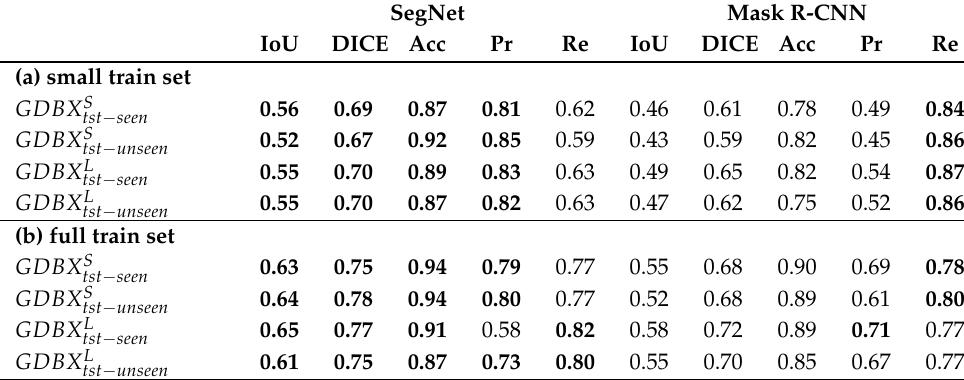
Table 4. Results for RQ1, RQ2: performance for test sets with previously seen and unseen cities for SegNet and Mask R-CNN trained on different large training sets, i.e., (a) GDBX S and (b) the full trn training data GDBX S and GDBX L . ‘Acc’ stands for accuracy, ‘Pr’ for precision, and ‘Re’ for recall. trn trn The best results are highlighted in bold. This clearly shows that SegNet outperforms Mask R-CNN. The latter architecture can only outperform SegNet in recall (Re), however, at the cost of precision (Pr), leading to overall lower performance (see DICE, which is in the case of binary segmentation equivalent to